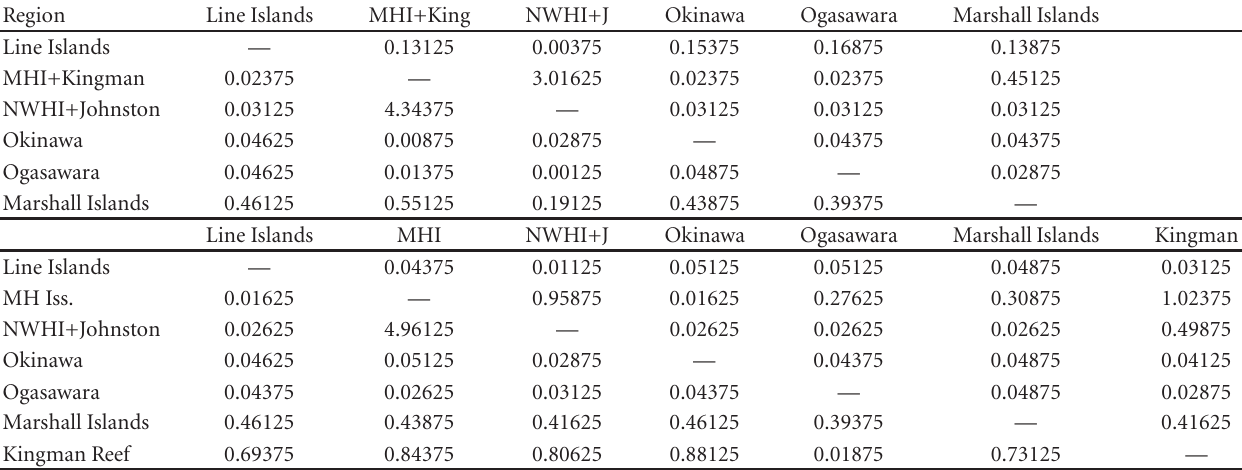
Table 4: Pairwise population migration rate estimates ( N e M ) based on a Bayesian MCMC simulation. Kingman Reef is grouped with the Main Hawaiian Islands in the upper table and treated as a seprate population in the lower table. The value of M calculated by MIGRATE was multiplied by the θ , as calculated by MIGRATE, of the destination population to estimate migration. The estimates of migration are separated by direction; the columns are source populations, and the the rows are sink populations. Line